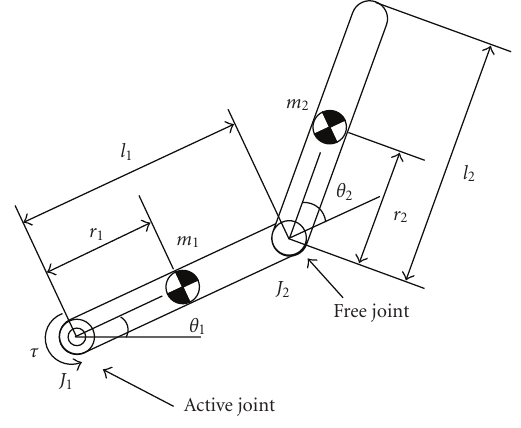
Figure 1: 2-link planner under actuated manipulator (2PUAM).